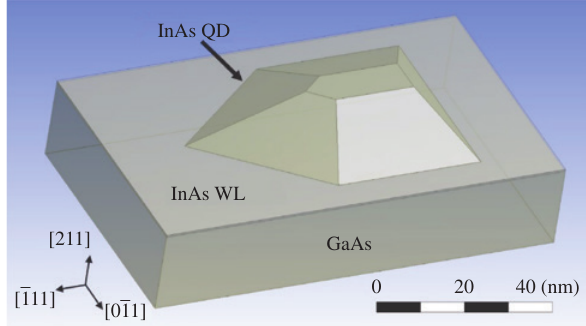
and (B) out-of-plane ε xx zz